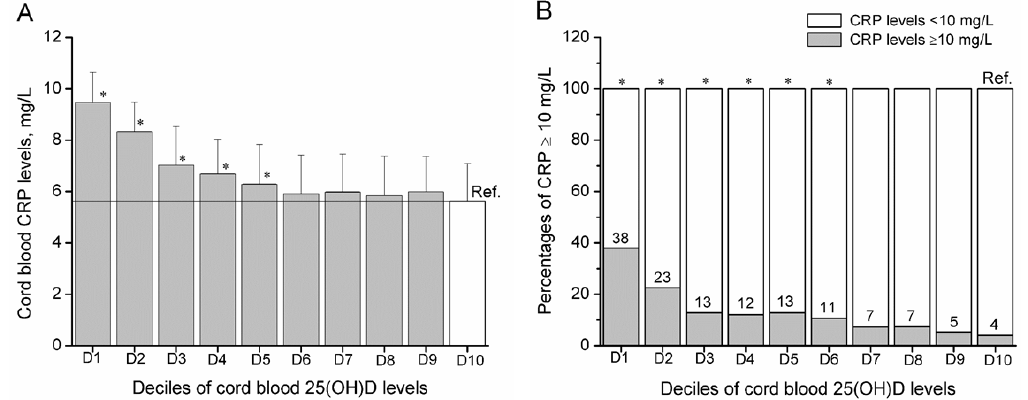
Figure 1. Means of cord blood CRP levels ( A ) and proportions of CRP ≥ 10 mg/L ( B ) across deciles of 25(OH)D levels in neonates ( n = 1491). Bars represent mean ± SD ( A ). D1, D2 and D3 mean the first, second and third decile respectively, and so on. ∗ Represents the significant difference with p < 0.05, compared to the tenth decile of 25(OH)D levels.